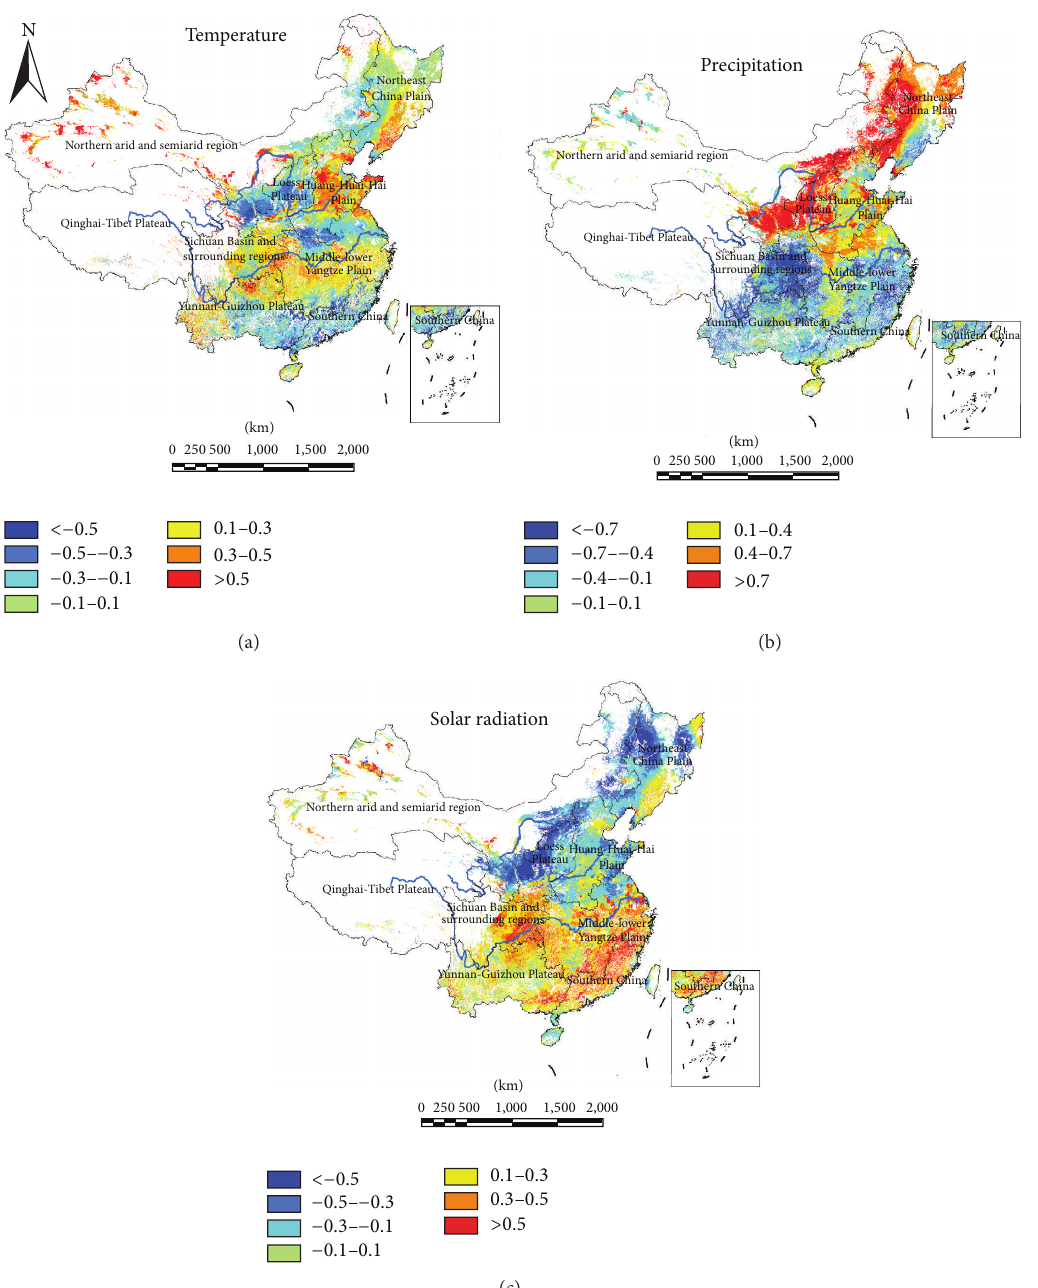
Figure 7: Correlation coefficients between production potential and climatic